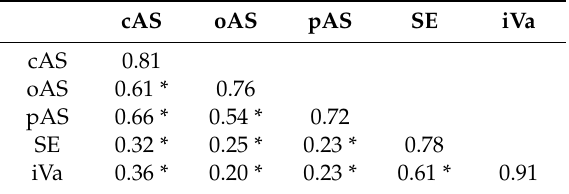
Table 1. Cronbach’s alpha coe ffi cients and correlations between